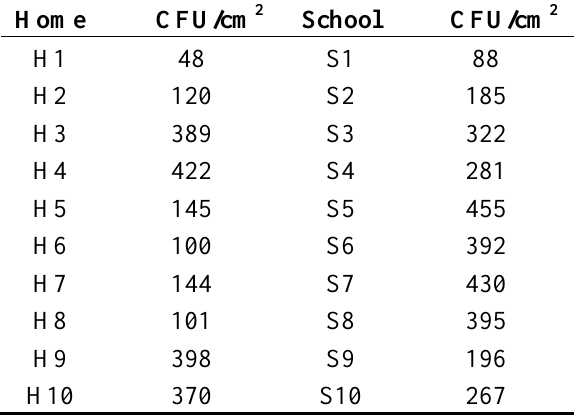
Samples H1, H2, S1, and S2 were taken from cold-water showers only. However, the other samples were taken from shower heads that supply both hot and cold water